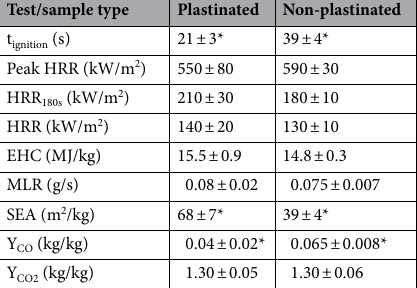
Test/sample type